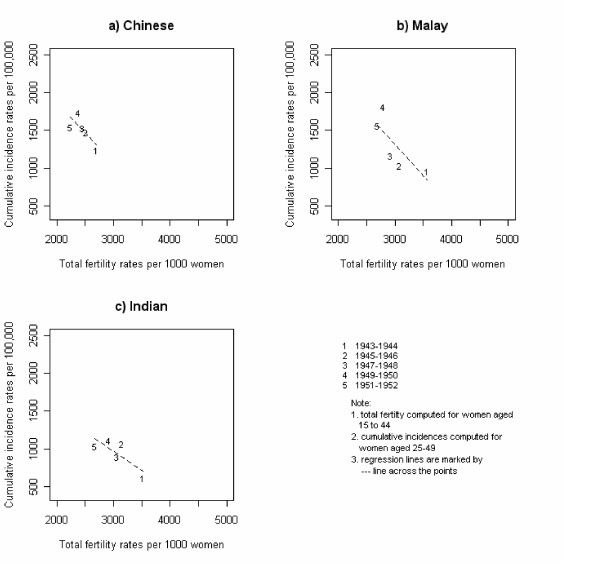
Scatterplots of cumulative breast cancer incidence rates per 100,000 women (for ages 25 to 49) and total fertility per 1,000 women (for ages 15 to 44) for cohorts 1943 – 1944, 1945 – 1946, 1947 – 1948, 1949–1950 and 1951–1952. Over time, decreased total fertility seems to be associated with increased cumulative rate of breast cancer incidence across three ethnic groups.